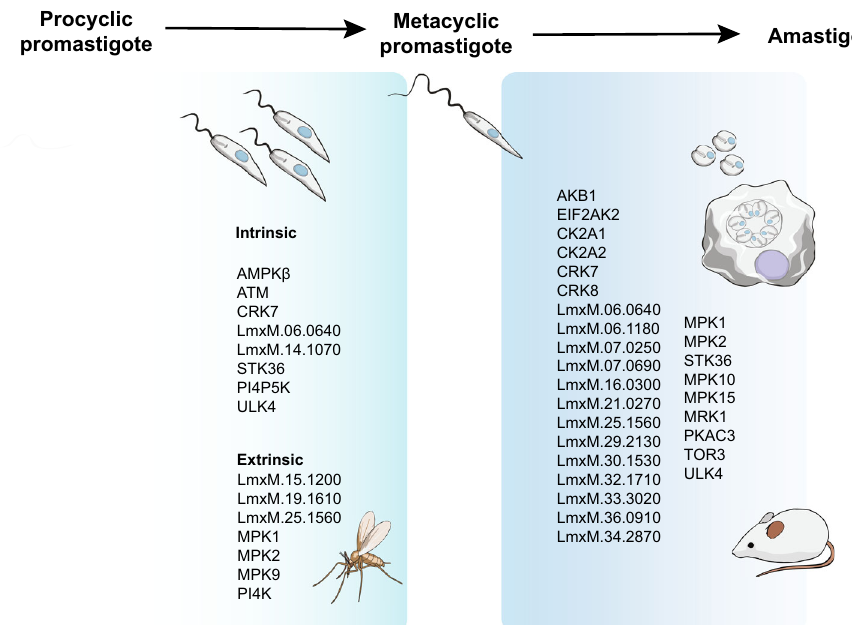
Fig. 7 Schematic representation of L. mexicana differentiation cycle. Fifteen protein kinases were identi fi ed as required for colonisation of the sand fl y. Twenty-nine protein kinases were identi fi ed as required for survival as amastigotes in vivo and in